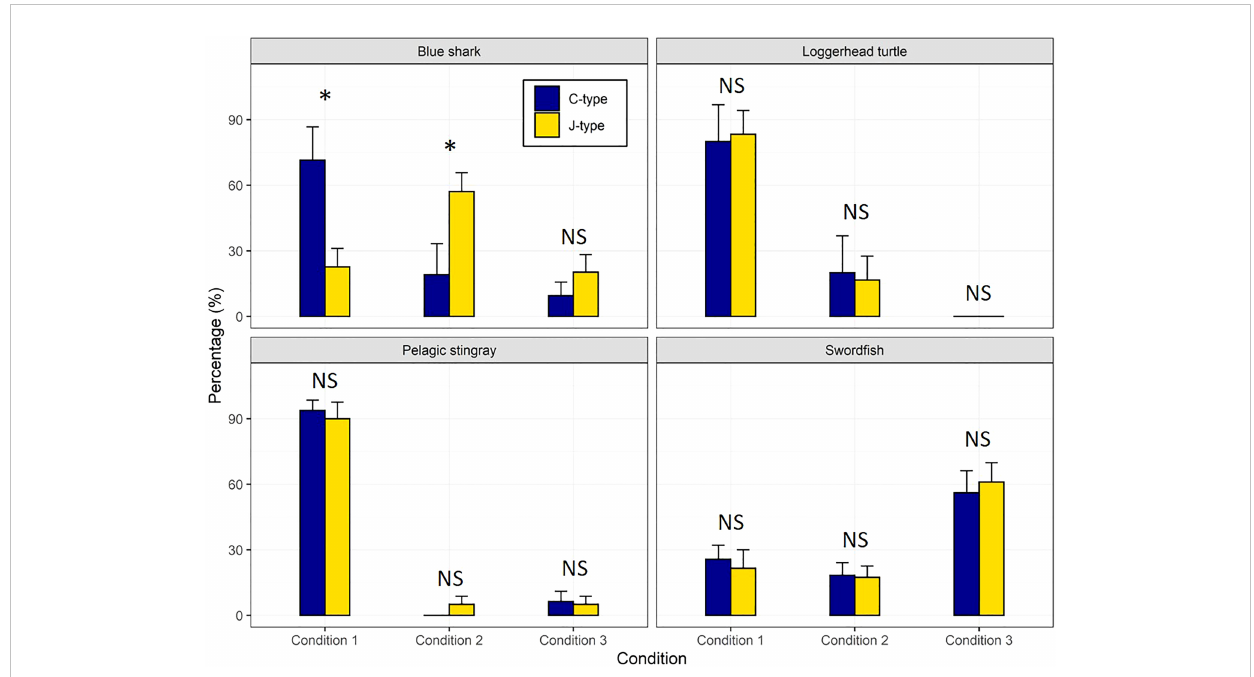
FIGURE 6 Percentage of specimens for each of the three capture conditions by species (blue shark, loggerhead turtle, pelagic stingray, and sword fi sh) and hook type (C and J). An asterisk (*) indicates a signi fi cant difference between hook types within a condition (p <.05) and “ NS ” (not signi fi cant) indicates that no differences were found between the hook types within a condition (Wilcoxon ’ s test; p